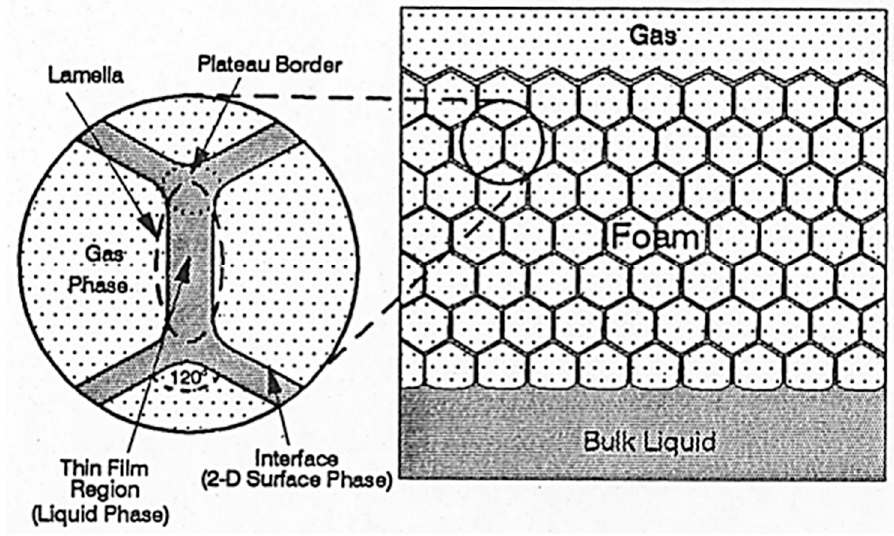
Figure 2. Foam system [25].